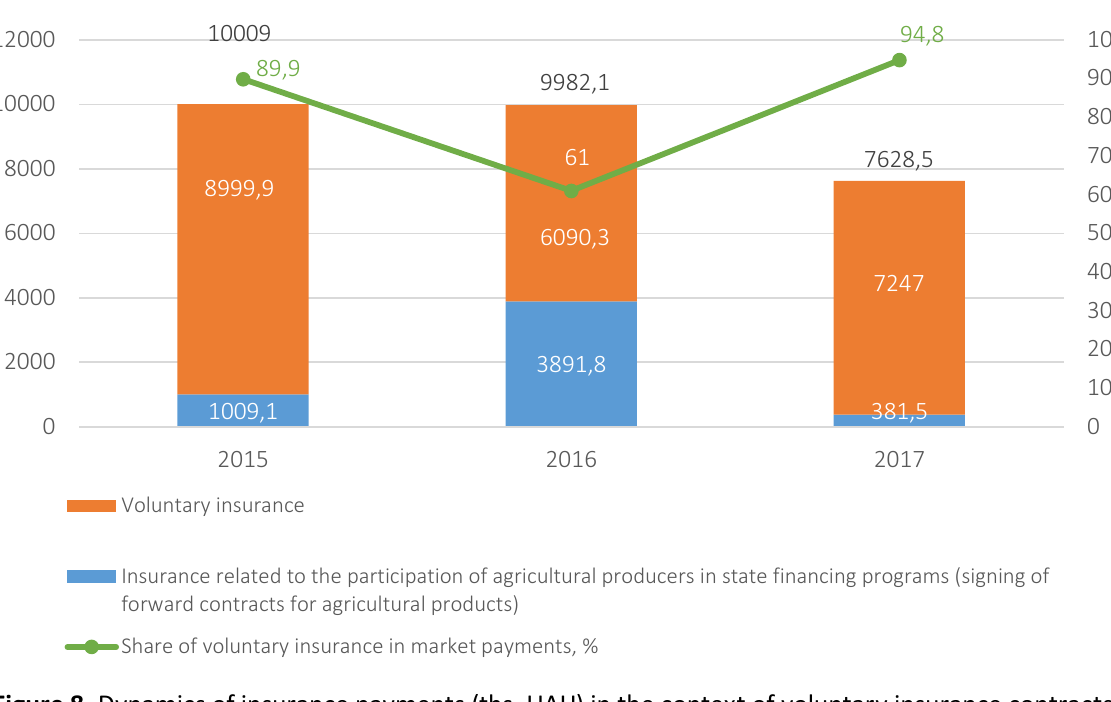
Figure 8. Dynamics of insurance payments (ths. UAH) in the context of voluntary insurance contracts